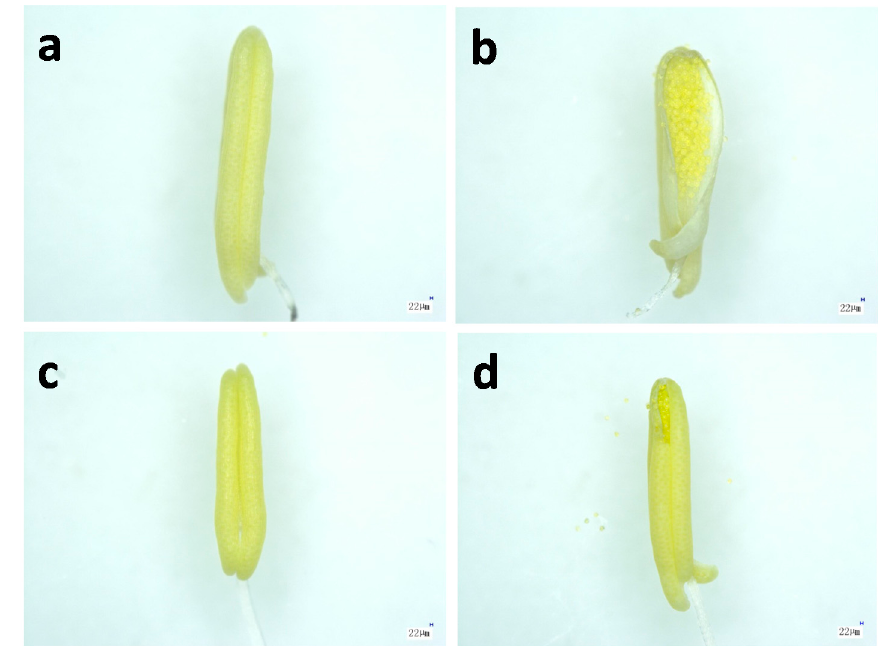
Figure 2. Anther morphology of SDWG005 and 9311 in the control and heat (38 °C for 12 h) treatments. Anthers of 9311 plants in the ( a ) control and ( b ) heat treatments, and anthers of SDWG005 plants in the ( c ) control and ( d ) heat treatments. Scale bar = 22 µm.